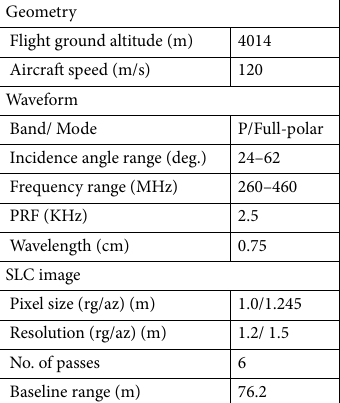
Table 1. Description of the TomoSAR Dataset acquired using P-band ONERA SETHI